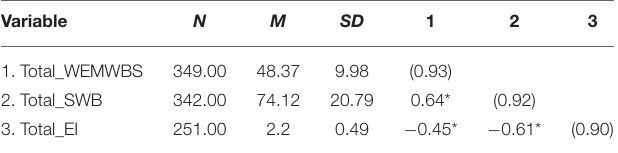
TABLE 2B | Totals for scales’ descriptive statistics and Pearson correlation coefficients’ statistics for Israeli sample. Variable